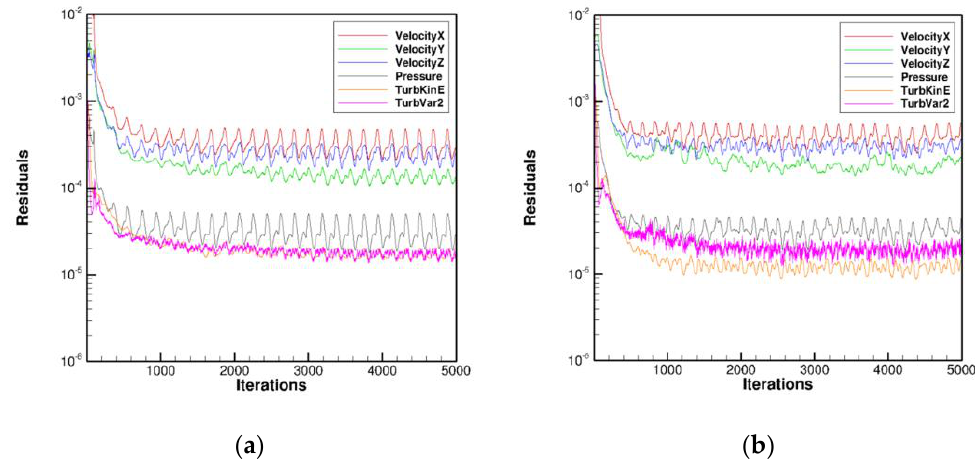
Figure 6. Residuals 𝐿 2 -norm of the shuttle tanker simulations, α = 0 °. ( a ) finest mesh; ( b ) coarsest mesh.